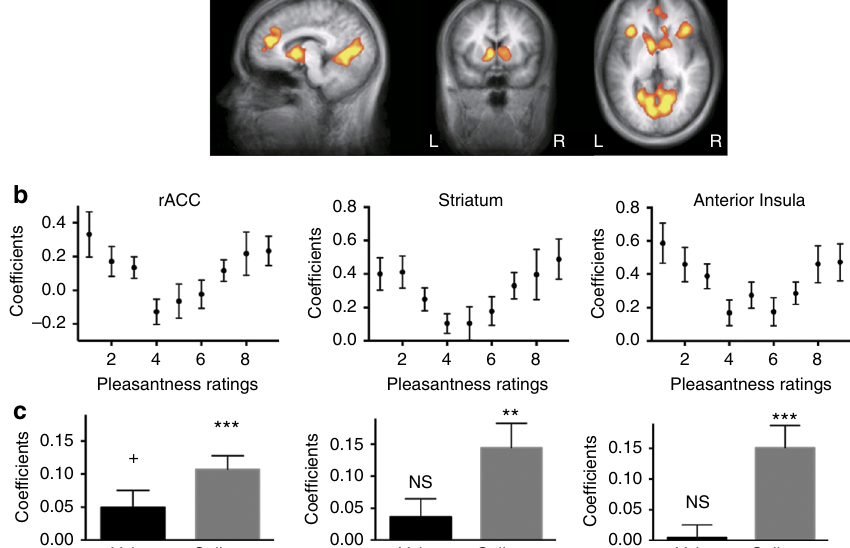
Fig. 3 Univariate saliency signals in the brain. a BOLD activity in the rACC, the bilateral striatum and anterior insula signi fi cantly correlated with cue saliency (per-voxel p < 0.005 and cluster-size thresholding at FWE p < 0.05). b Activity levels of these regions showed a U-shaped pro fi le as a function of pleasantness ratings. Data were extracted from ROIs de fi ned by a LOSO procedure ( n = 18). c The effects of value and saliency on the activity of these brain regions were assessed in the same LOSO ROIs, using a GLM with both value and saliency parametric regressors. Across all these regions, there was a signi fi cant saliency effect while value was not signi fi cant. rACC rostral anterior cingulate